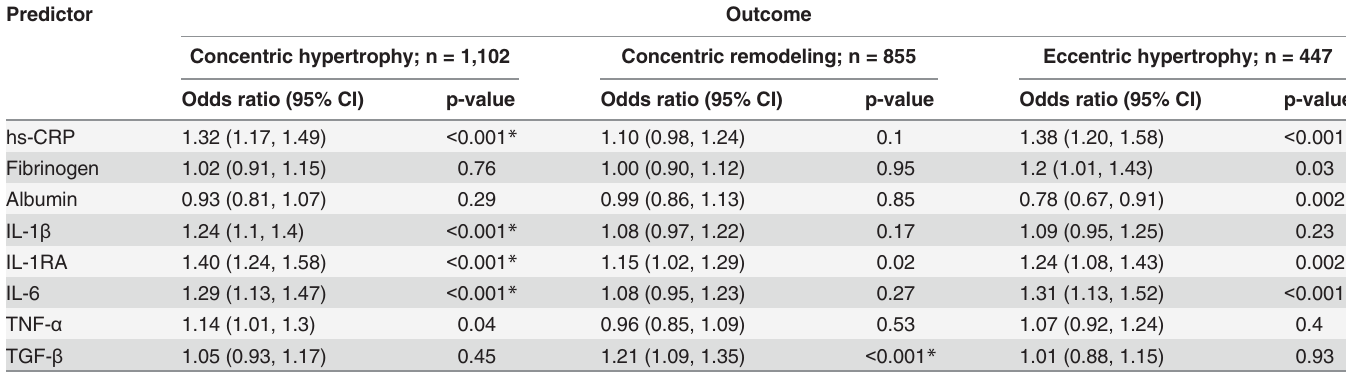
Table 4. Adjusted multinomial logistic regression models showing the association of inflammatory biomarkers with cardiac geometry.